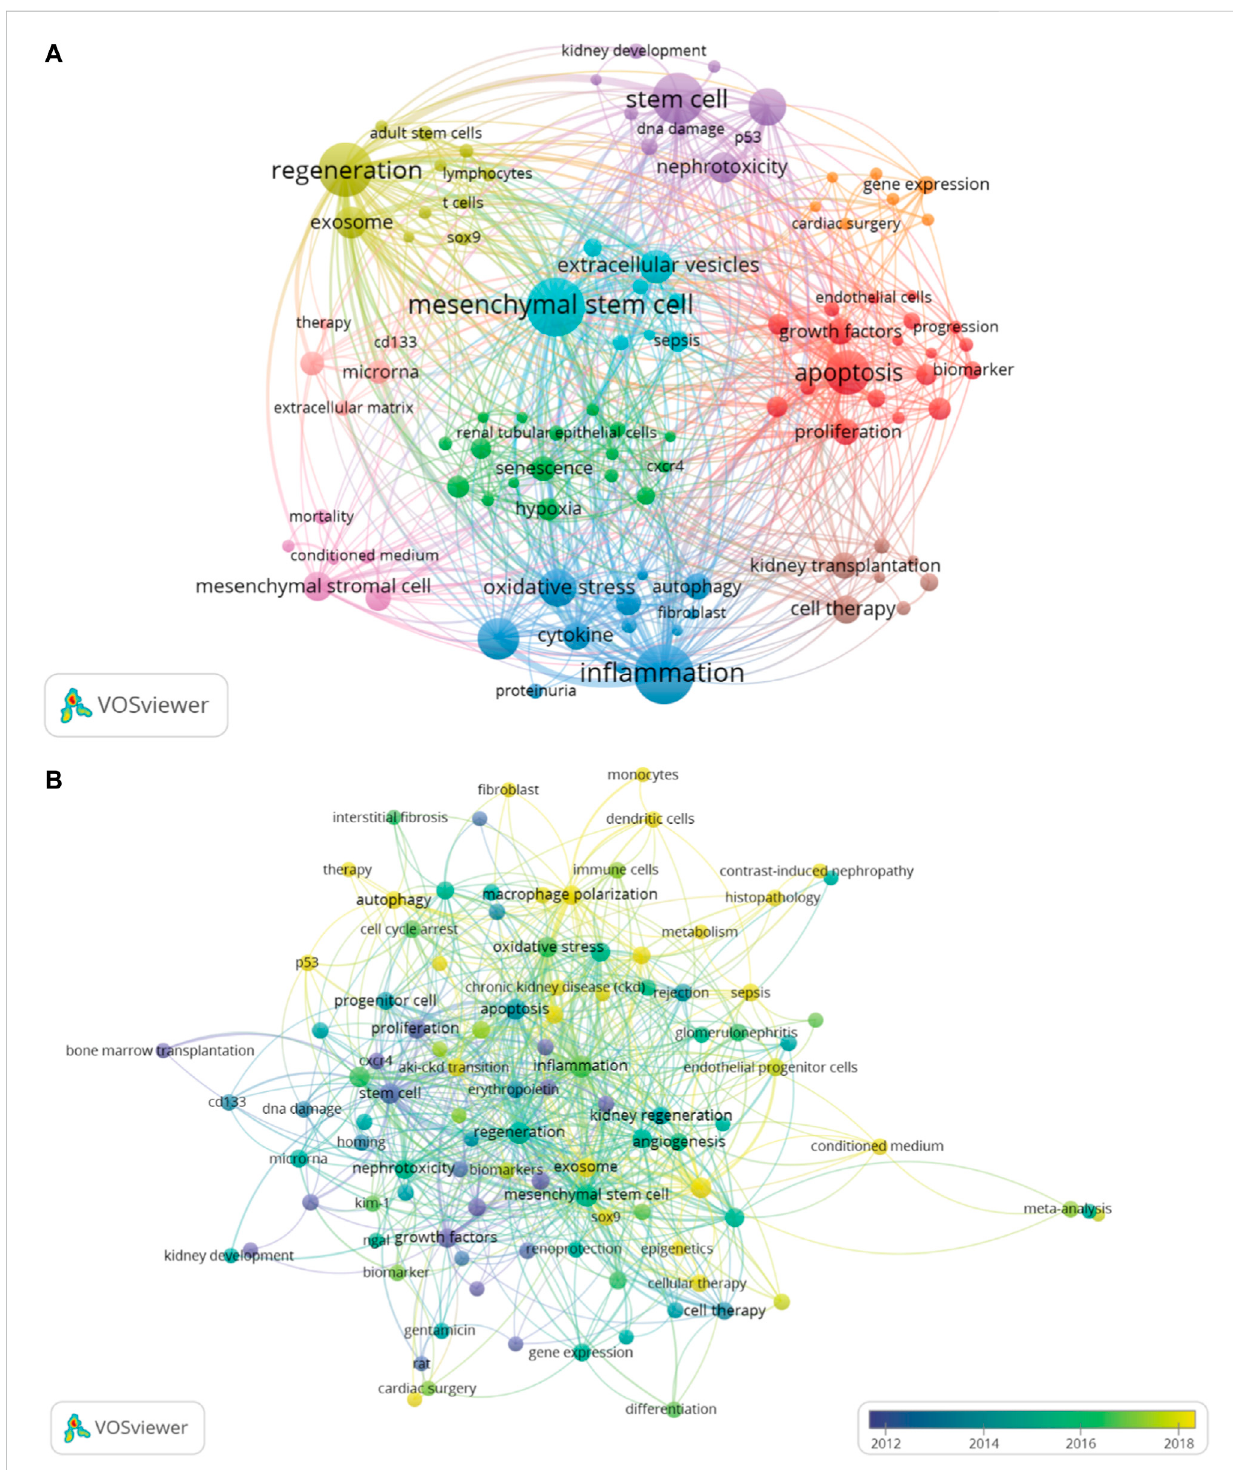
FIGURE 8 Theauthorkeywordsco-occurrencenetworkmap,whichshowedthedistributionofclustersofmajorkeywords (A) .Theoverlaymapdisplayedthat author keywords are colored based on average occurrence time (B) . The overlay visualization map showed the color change of the author keywords based on average occurrence